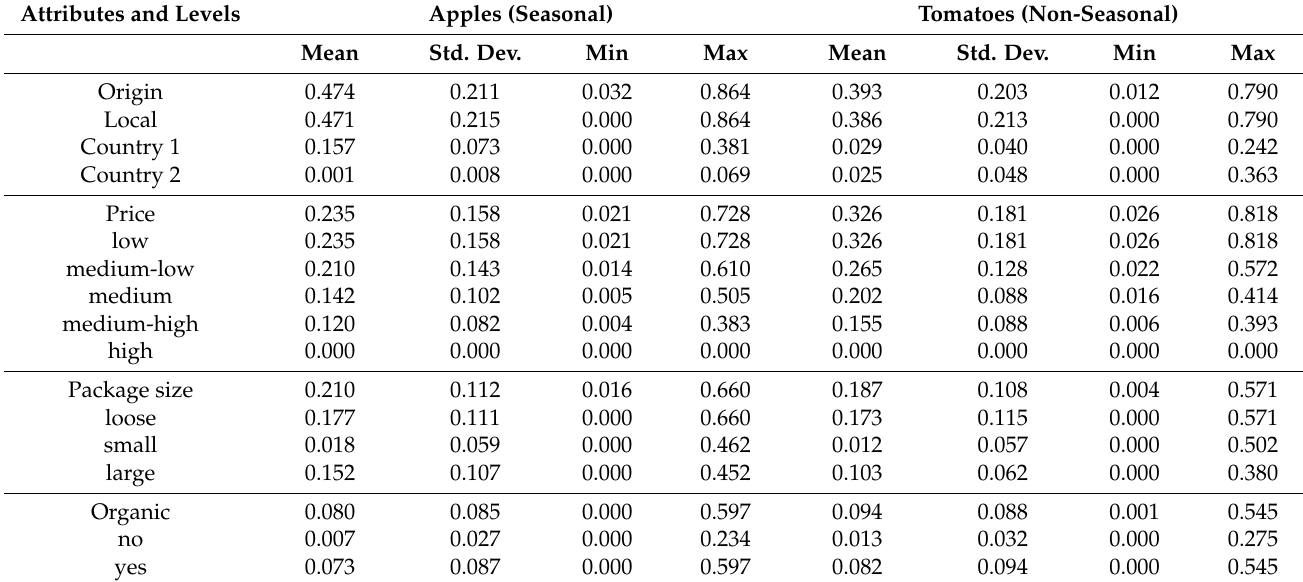
Table 3. Estimated part-worth utilities